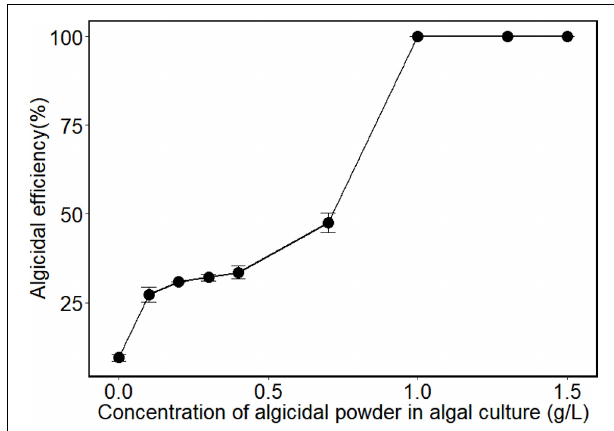
FIGURE 2 | Algicidal efficiency of the algicidal powder against A. sanguinea at different concentrations (Algicidal powder was made from the cell-free fermentation broth after 14 h of fermentation). Values are means ± s.e, n =